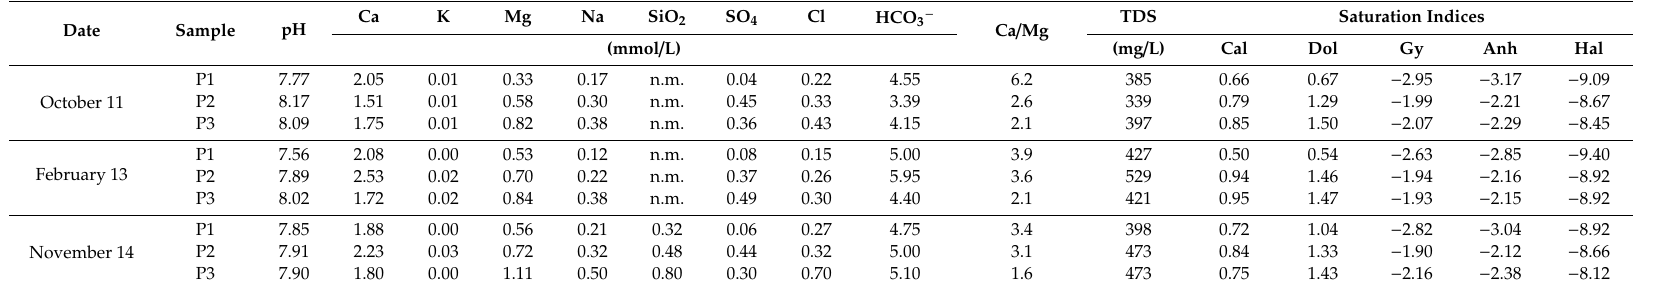
Table 3. Chemical composition of the groundwater in the Diezma landslide in the di ff erent sampling campaigns. The table also shows some calculations such as the Ca / Mg ratio, the TDS (total dissolved solids), and the saturation indices with respect the main mineral phases such as calcite (Cal), dolomite (Dol), gypsum (Gy), anhydrite (Anh), and halite (Hal), n.m.: not measured.